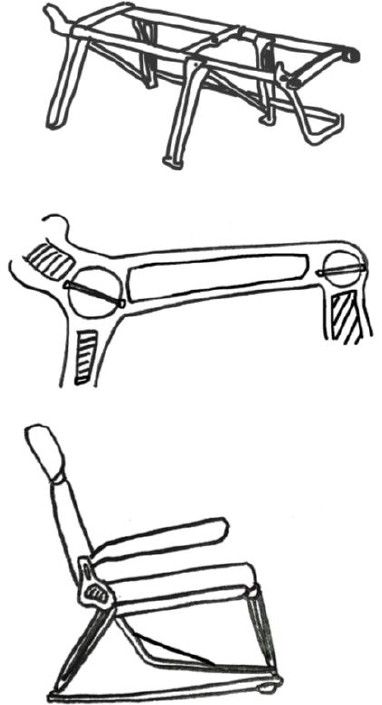
Figure 17. U.S. Patent 4,229,040 Triangular support saves cost and materials [19].